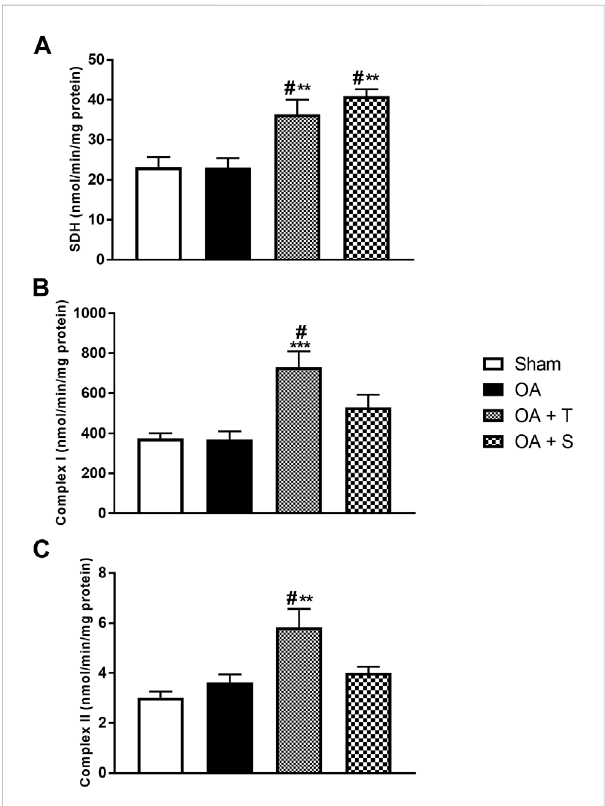
FIGURE 2 Activity of the components of the respiratory chain. (A) SDH; (B) Complex I; (C) Complex II. Abbreviations: OA, osteoarthritis; SDH, succinate dehydrogenase. Data are presented as mean ± SEM, in which: # p < 0.05vs.ShamGroup;** p < 0.01vs.OAGroup;*** p < 0.001 vs. OA Group; (One-way ANOVA followed by Tukey post-hoc test).